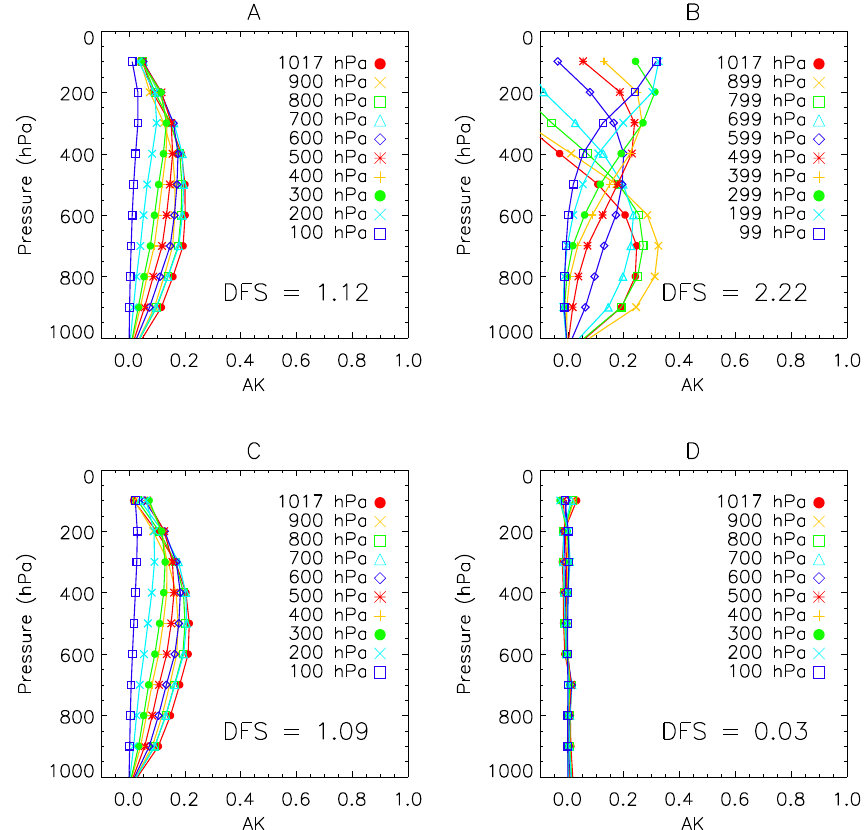
Fig. 11. Same as Fig. 10, but for MOPITT V4. All comparisons are for over the ocean and during the daytime of 1 September 2007, over the Southern Africa region.